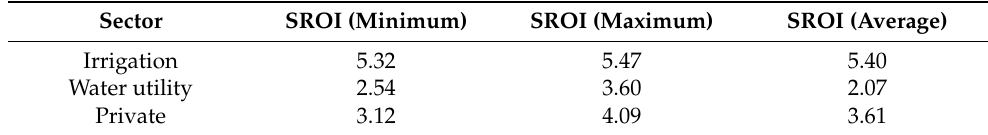
Table 11. SROI range across all sensitivity tests, excluding Test